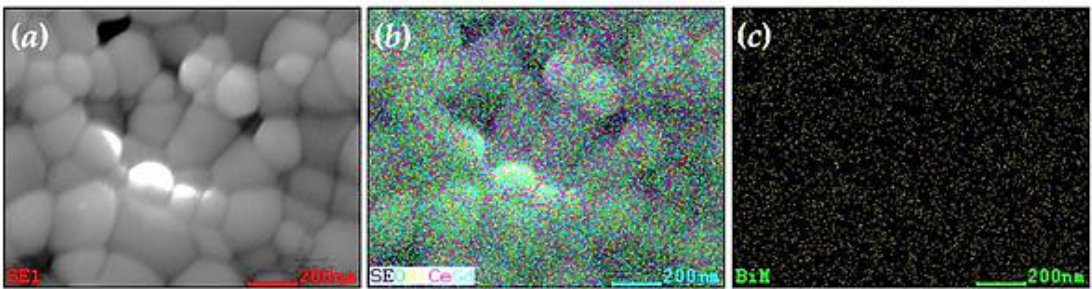
Figure 4. Elements mapping by EDS of sample 2Bi sintered at 1250 °C for 3 h: ( a ) area of the sample, ( b ) mapping of all elements and ( c ) mapping of Bi.